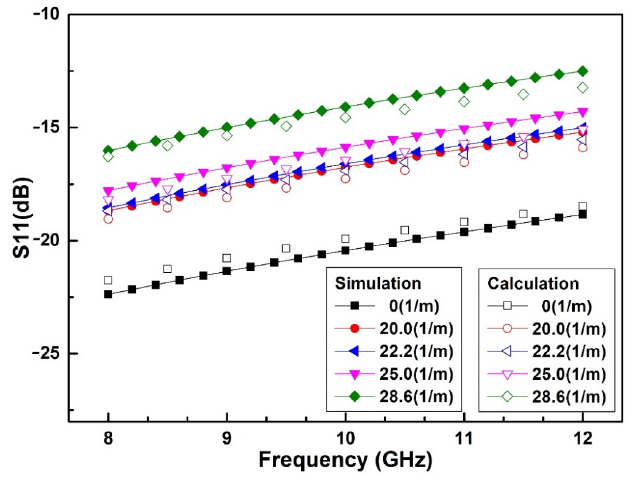
Figure 6. Simulated reflection loss S 11 of the spring-like double-clamped beam switch with different substrate curvatures.